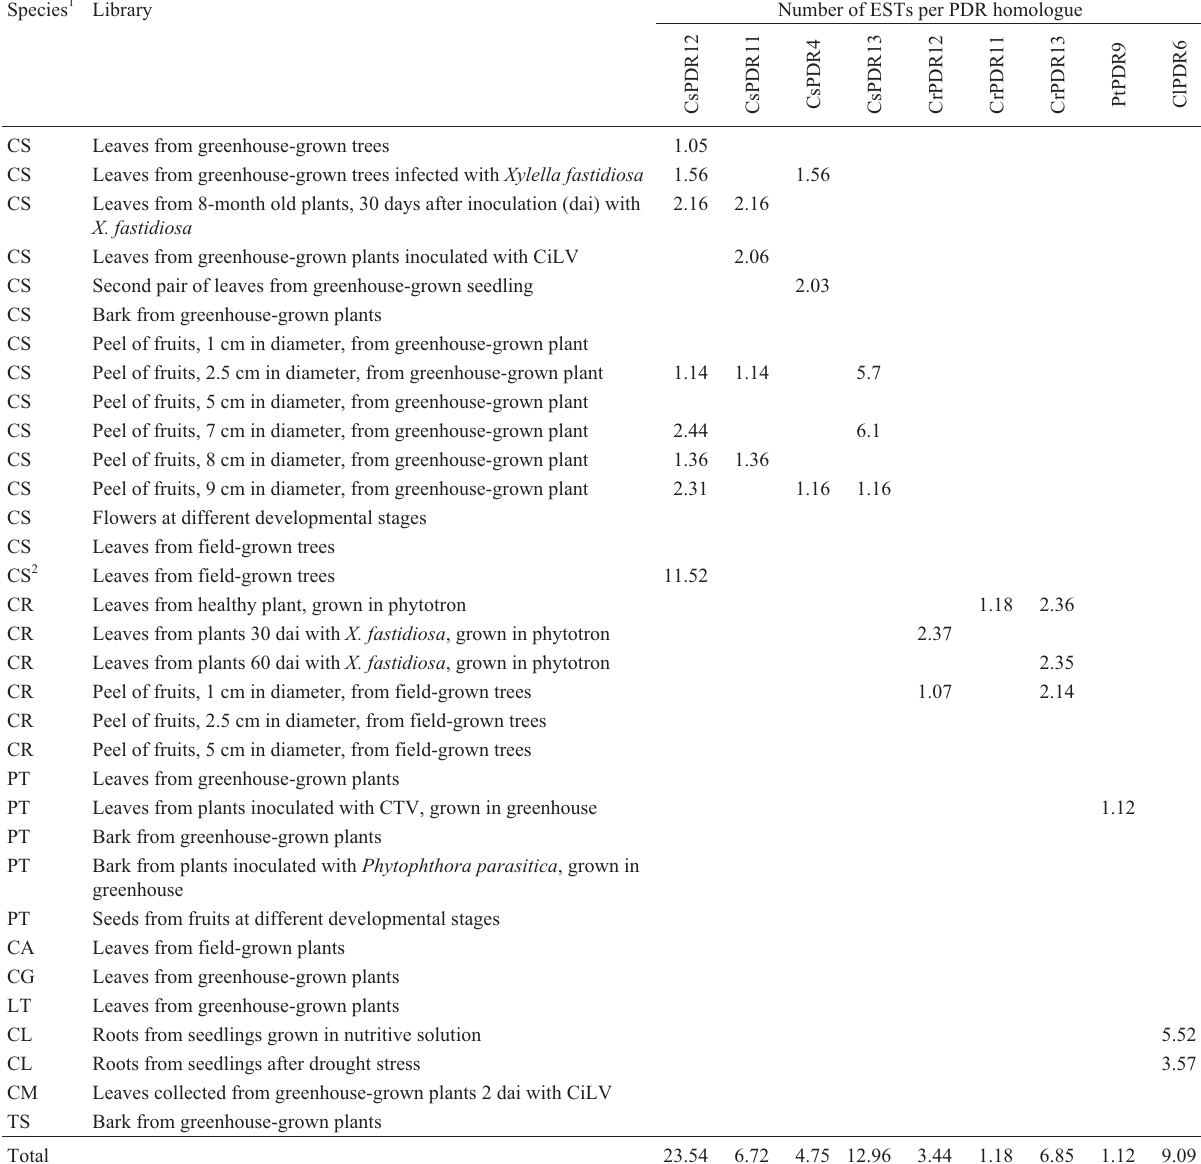
Table 3 - List of citrus cDNA libraries and PDR homologues (normalized for 10,000 ESTs per library). Species 1